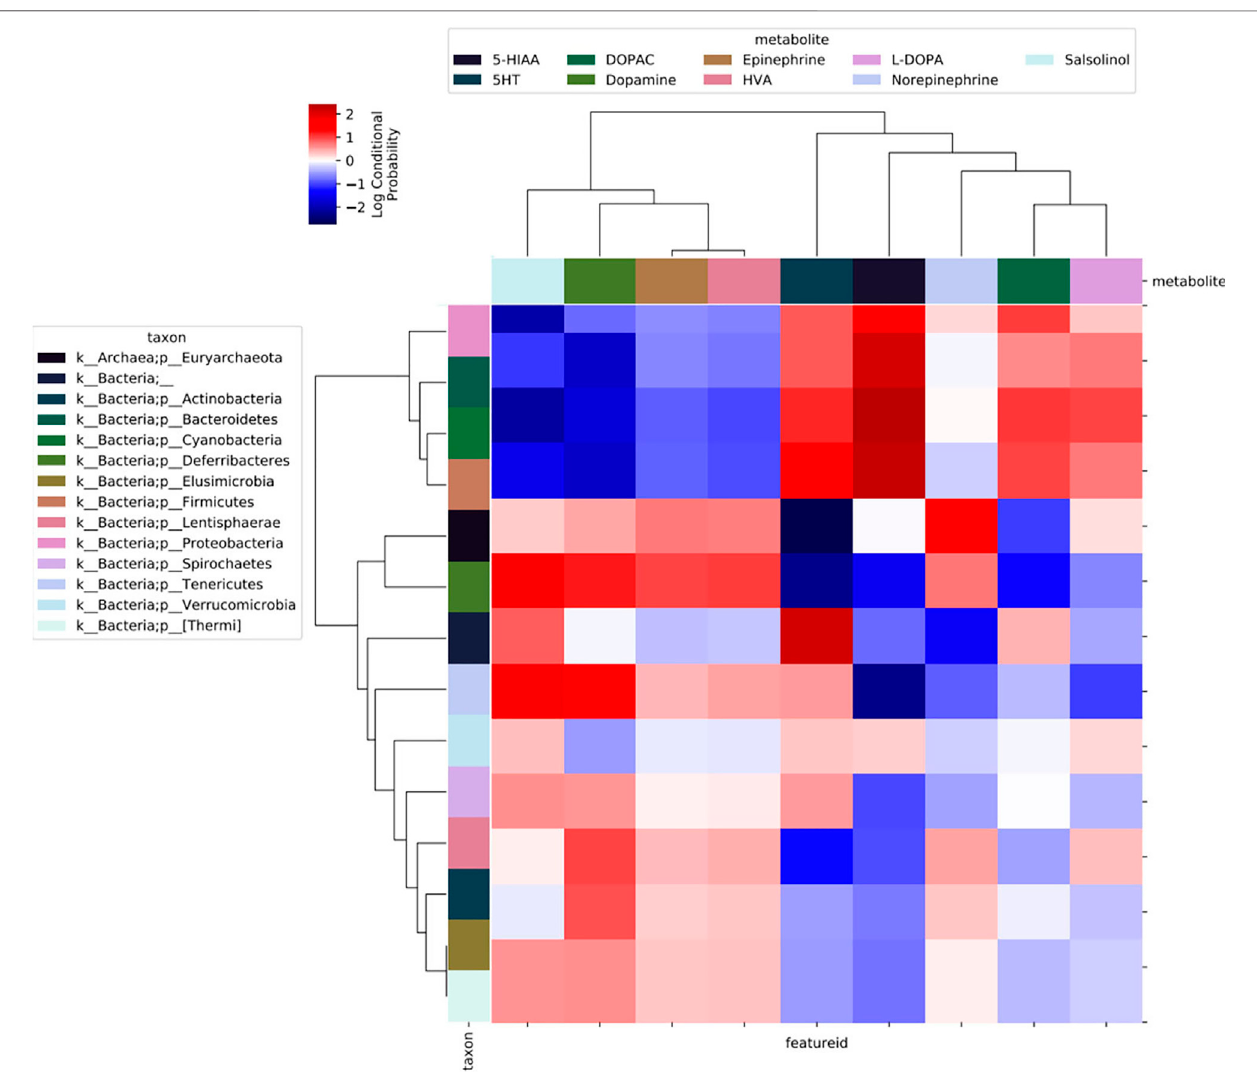
FIGURE 8 | Heatmap output of QIIME2 mmvec plugin analyses of microbe-metabolite co-occurrences. Darker shades of red indicate higher levels of co- occurrences between bacterial phyla and neurochemical metabolites.